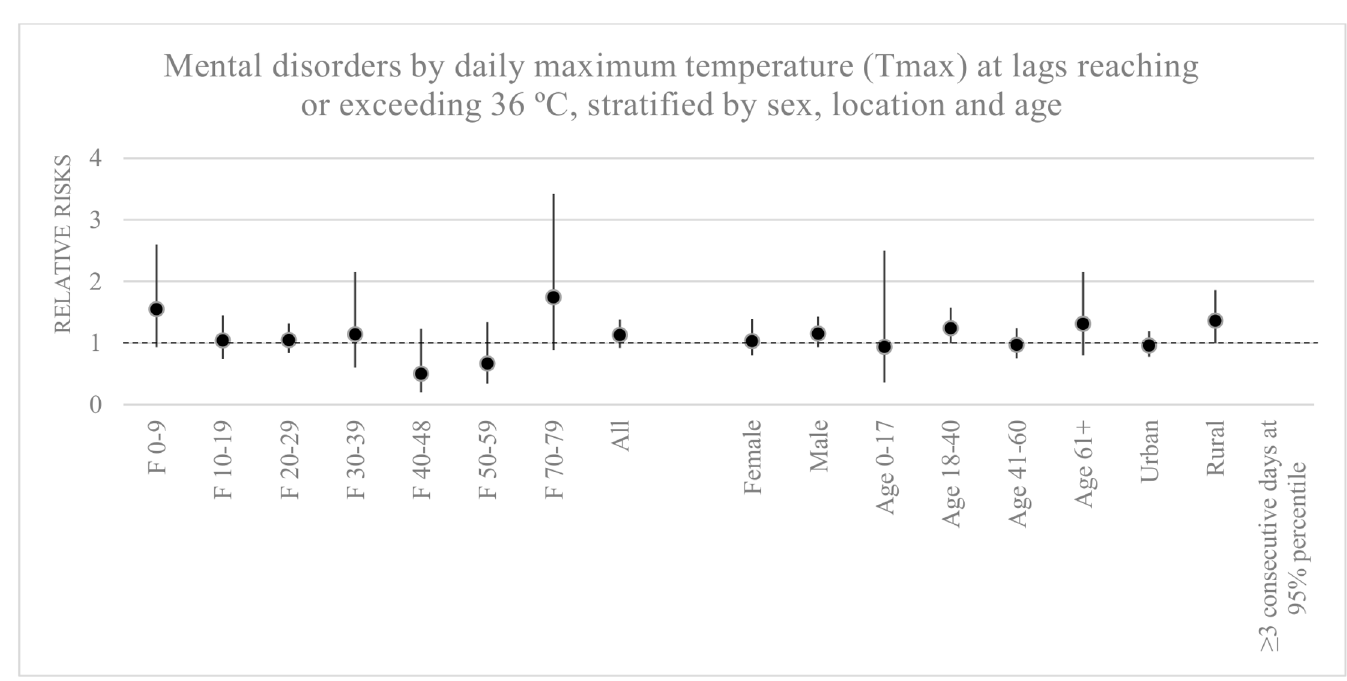
Fig 7. Mental disorders by daily maximum temperature at lags reaching or exceeding 36°C (at 95 th percentile of maximum temperature) stratified by sex, locations and age groups. Hospital visits in the groups F0-9, F70-79, males, and residents in the rural area were affected by heatwaves more than others.